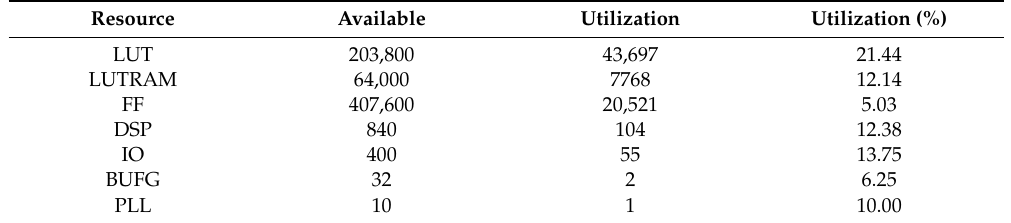
Table 3. The utilization results of the postimplementation of the FRMCO with 500 samples in 20 groups. Resource Available